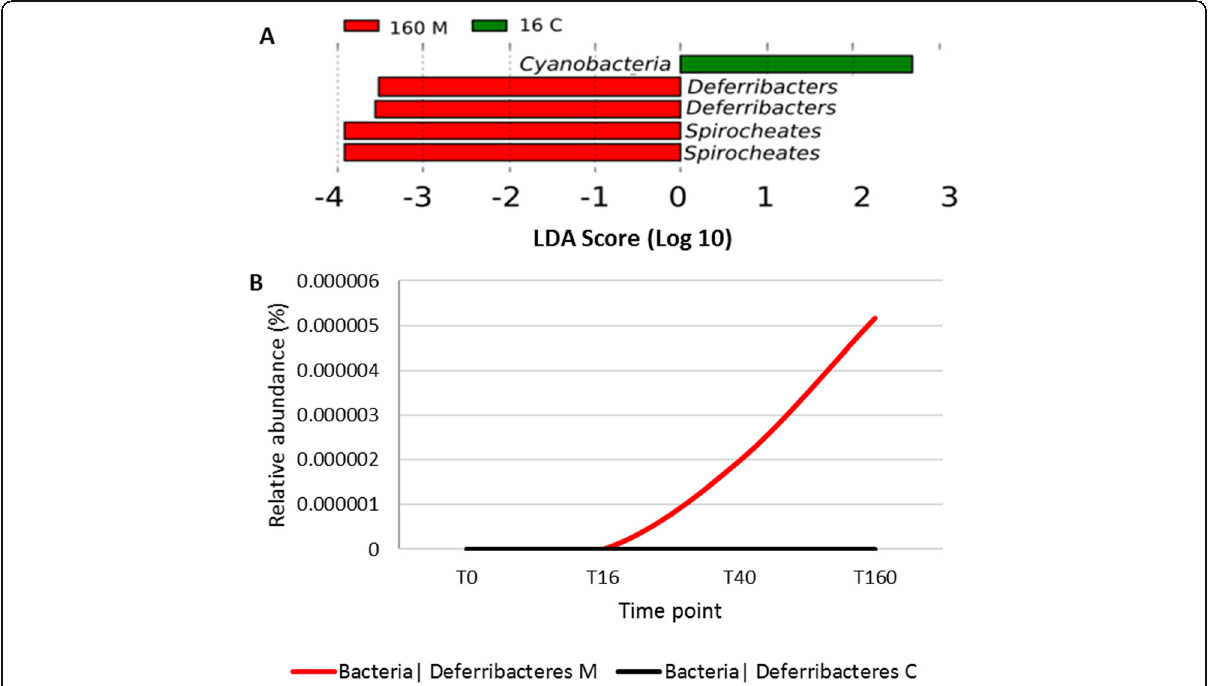
Fig. 1 a LEfSe plot of OTUs differing in relative abundance between the moxidectin treated horses at 160 h post treatment (160 M) and in the control group at 16 h post treatment (16C) at genera taxonomic level. b Relative abundance of Deferribacter spp. in moxidectin (M) and control c groups at phyla prior to and following